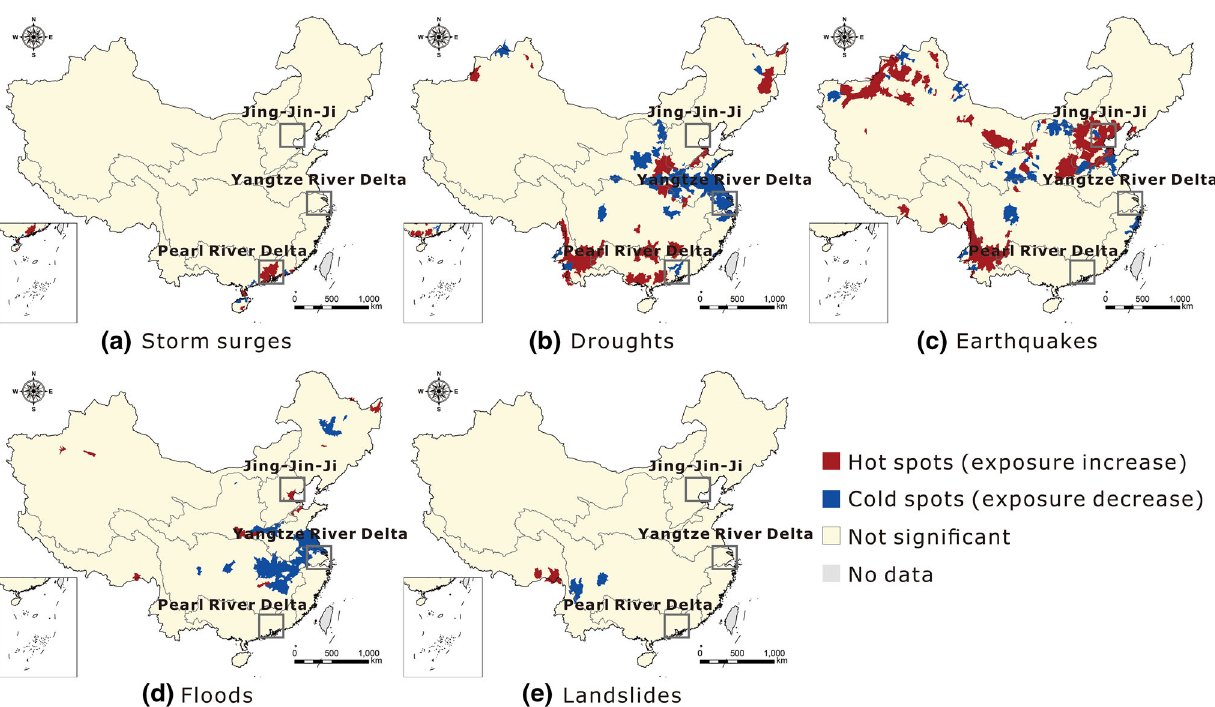
Fig. 7 Hot/cold spots of changes in cropland exposure to hazards in China from 1995 to 2005. Jing-Jin-Ji: Beijing-Tianjin-Hebei region